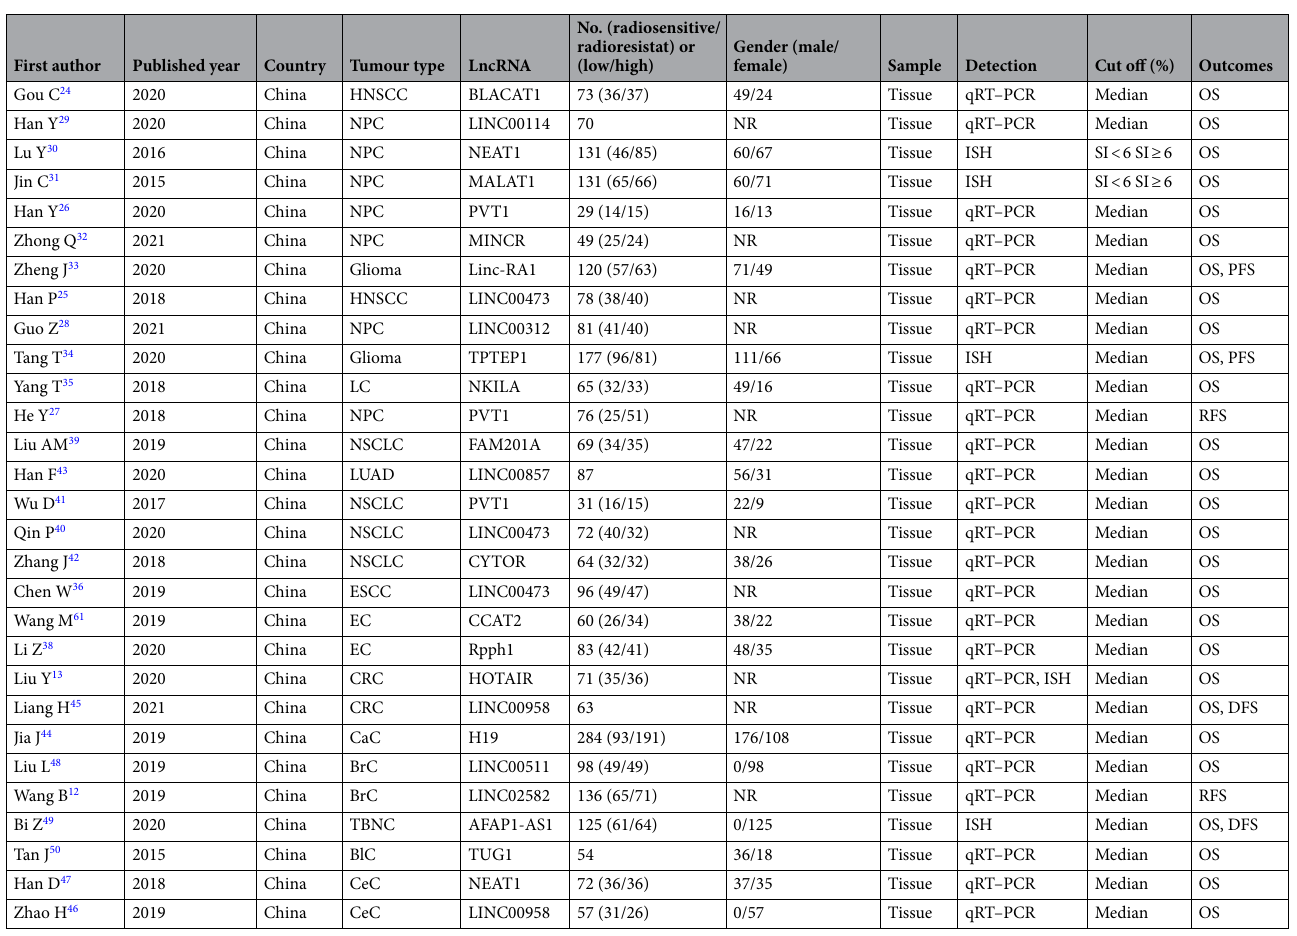
Table 1. Characteristics of studies included in this meta-analysis. NR not reported, HNSCC head and neck squamous cell carcinoma NPC nasopharyngeal carcinoma, ESCC esophageal squamous cell carcinoma,